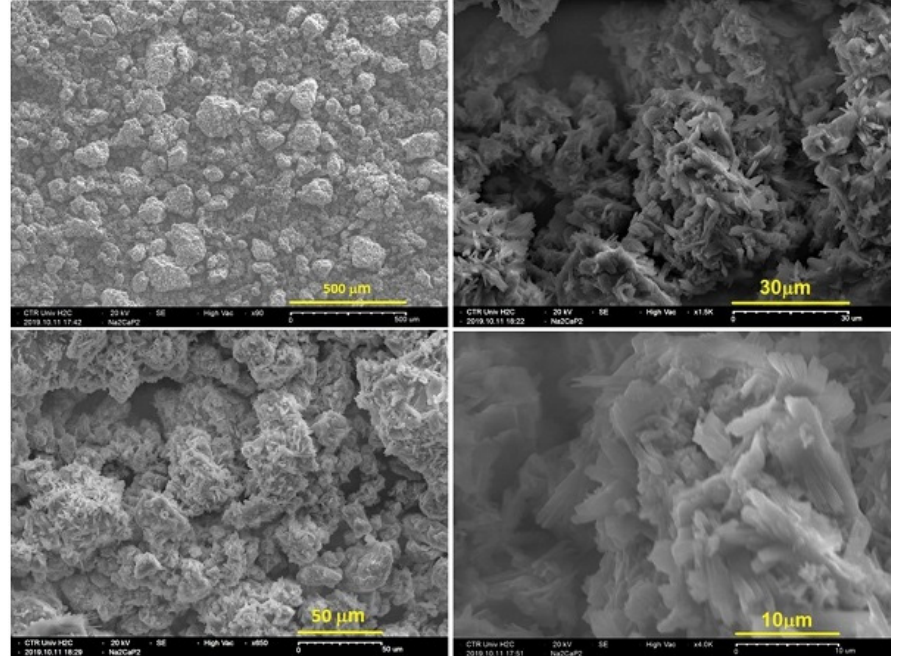
Figure 4. SEM images of Na 2 CaP 2 O 7 at different magnifications. Transmission electron microscopy (TEM) was further used to study the morphology and microstructure of Na 2 CaP 2 O 7 . Figure 5 shows rod-like nanoparticles that agglomerate to form superstructures with different grain crystal aspect ratios. The powder forms show irregular grains with a lateral size of 90–150 nm. The specific surface of the Na 2 CaP 2 O 7